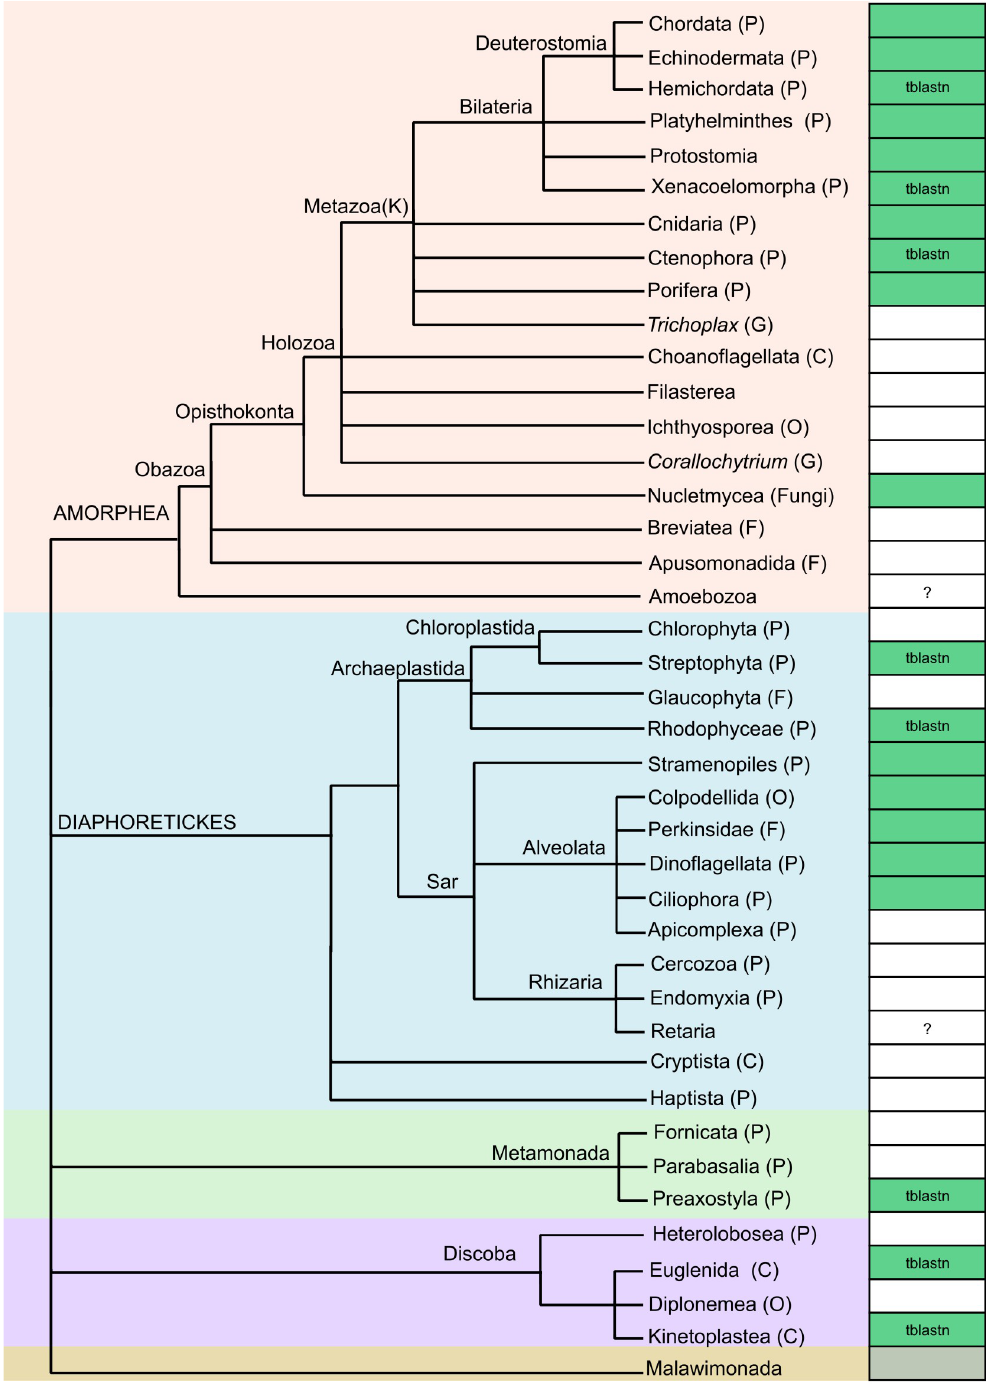
PLOS ONE | https://doi.org/10.1371/journal.pone.0251133 May 6,